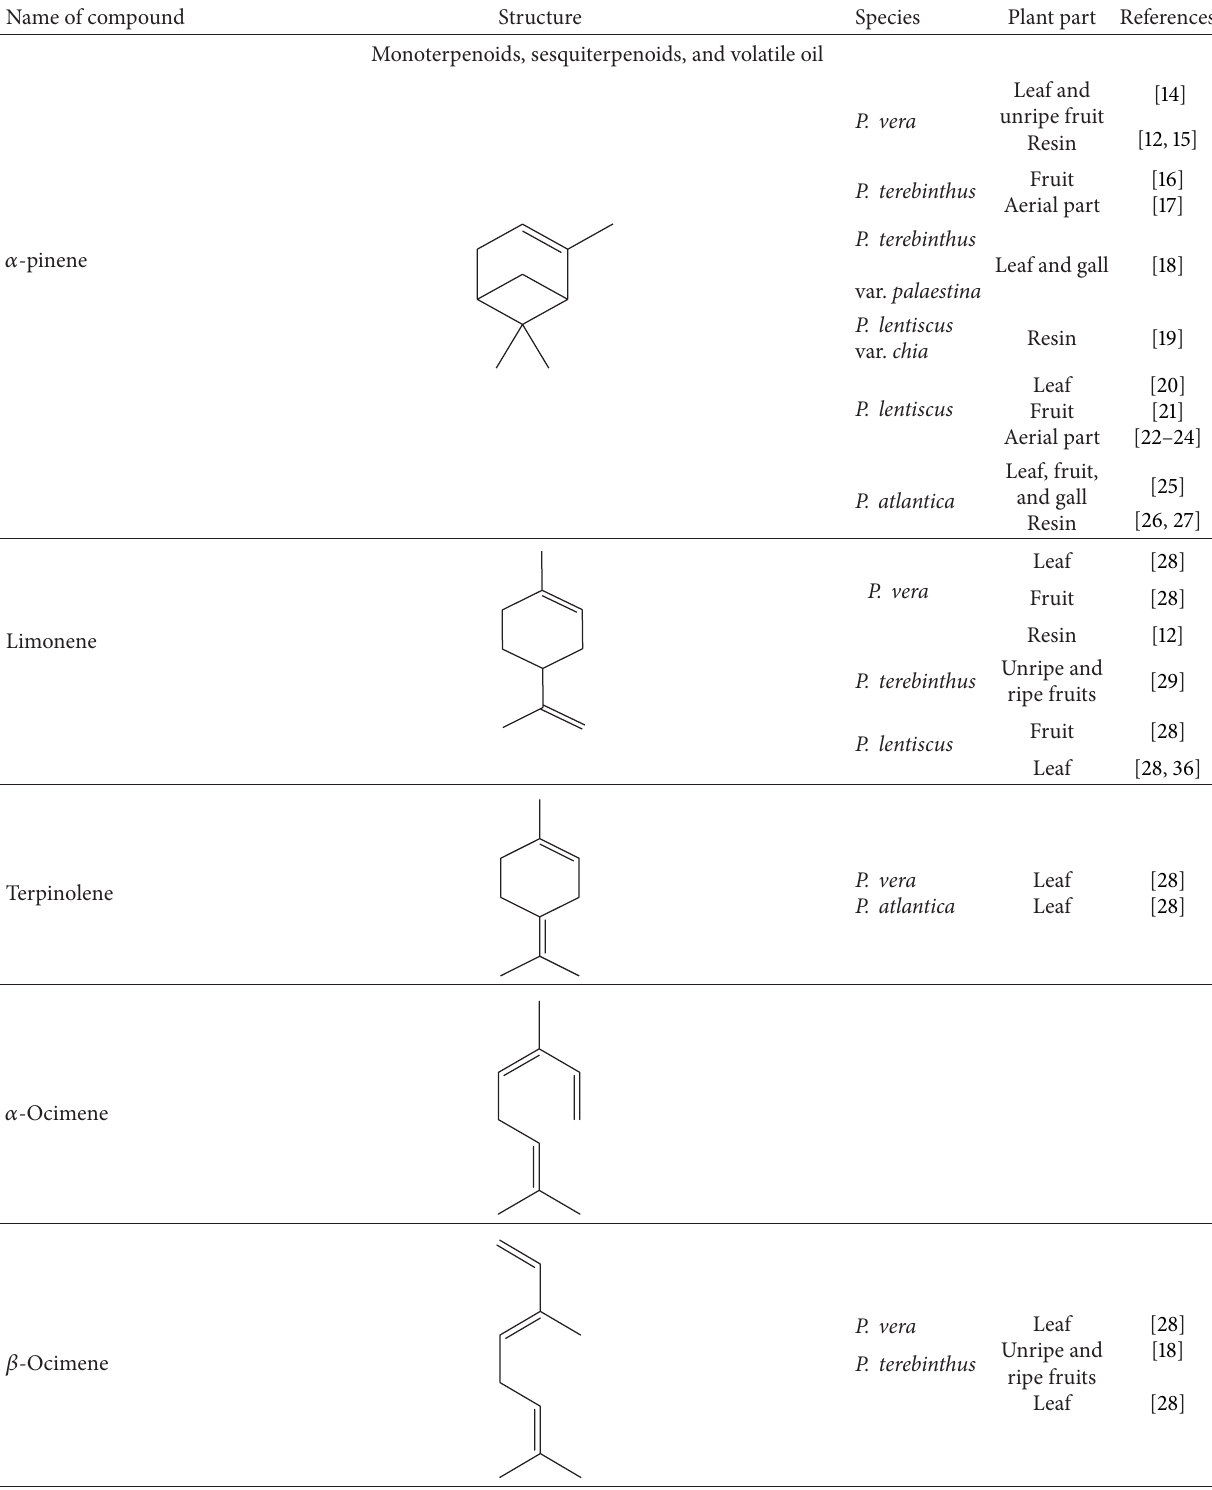
Table 2: Chemical compounds isolated from selected Pistacia